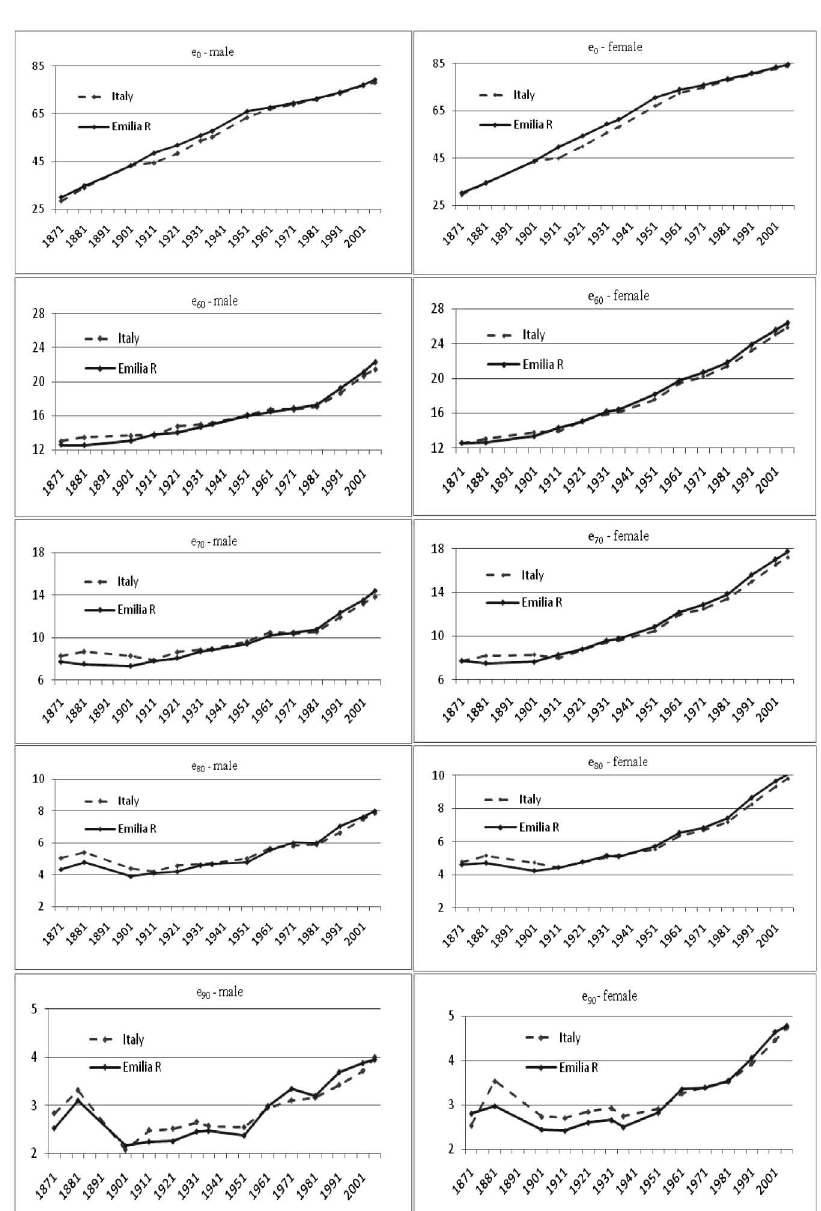
Figure 1 – Life expectancy at various ages – Emilia Romagna and Italy (1871-2007). High levels of infant mortality shape the 1871 and 1921 curves, and still appear in 1951, while in 2007 the rectangularization of the survivors curve is clearly visi- ble. Gender differences are noticeable from 1921 on, and become more evident in 1951 and, above all, in